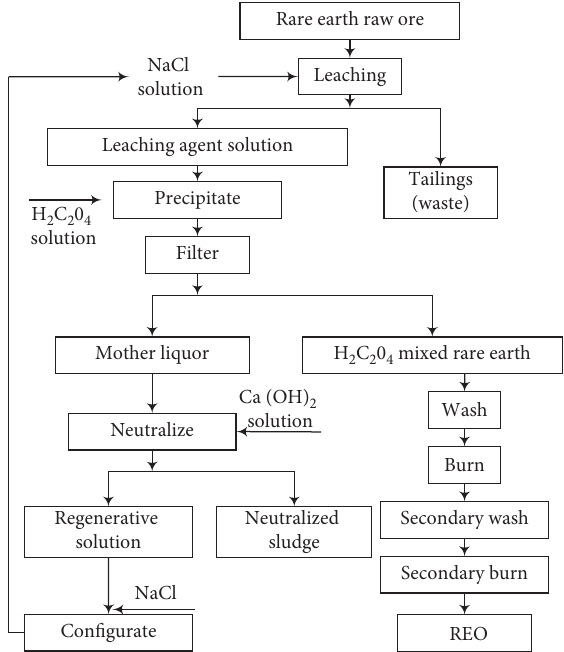
Figure 1: Weathered crust elution-deposited rare earth ore first- generation process.